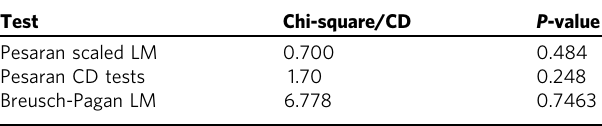
Table 3 Unit root test at level and fi rst difference.